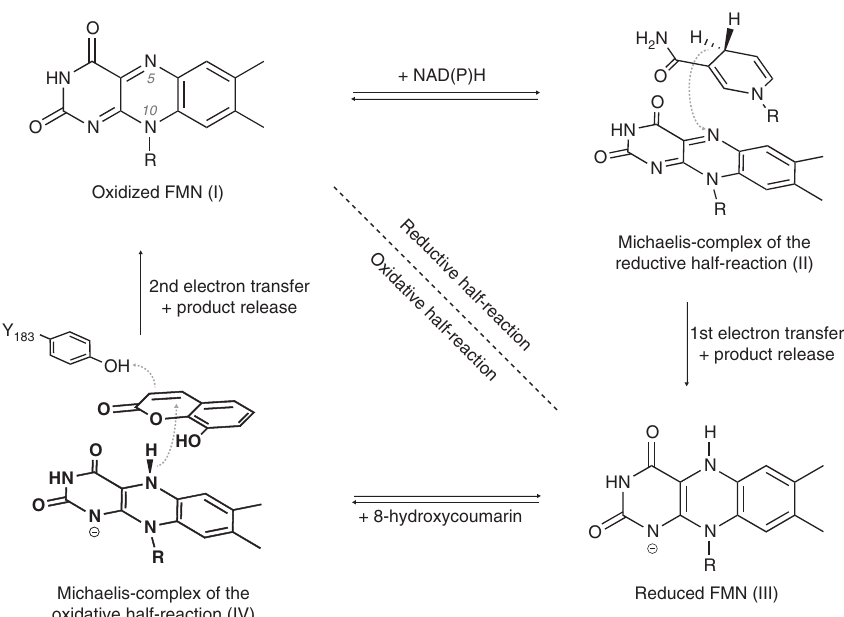
Figure 1 | Reaction mechanism of the flavin-dependent oxidoreductase XenA. XenA catalyses the NAD(P)H-dependent reduction of various a , b -unsaturated carbonyl compounds like 8-hydroxycoumarin following a ping-pong mechanism 3,6 . The overall reaction cycle can be divided into a reductive and an oxidative half-reaction, reflecting the oxidation state changes of the enzyme-bound flavin mononucleotide cofactor (FMN). Both half-reactions proceed via Michaelis complexes (II, IV). The proposed mechanism of the oxidative half-reaction proceeds by a trans -addition of a hydride transfer from flavin N5 and a proton from Y183 acting as a general acid by protonating the a -carbon of the a , b -carbon double bond of the substrate 7,43,52